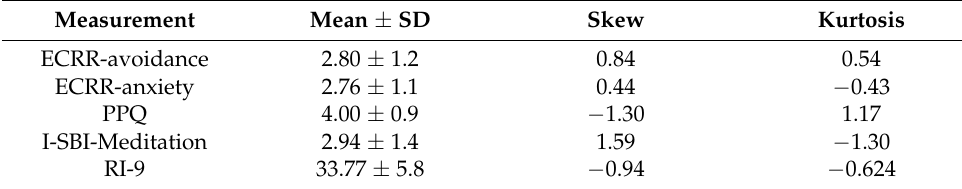
Table 2. Descriptive characteristics of the measurements ( n =